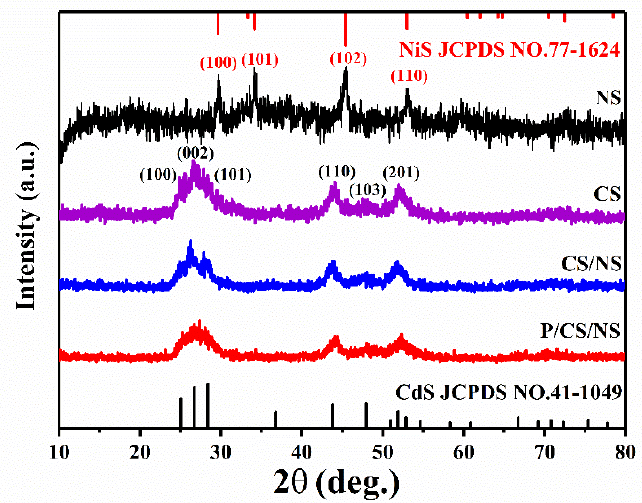
Figure 2. XRD pa tt erns of NiS, CdS, CdS/NiS, and